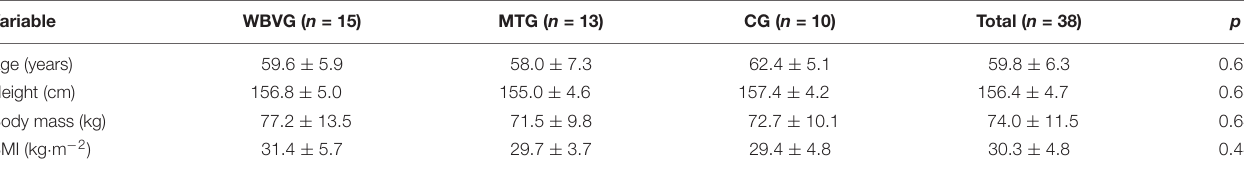
TABLE 1 | Descriptive data of each group.